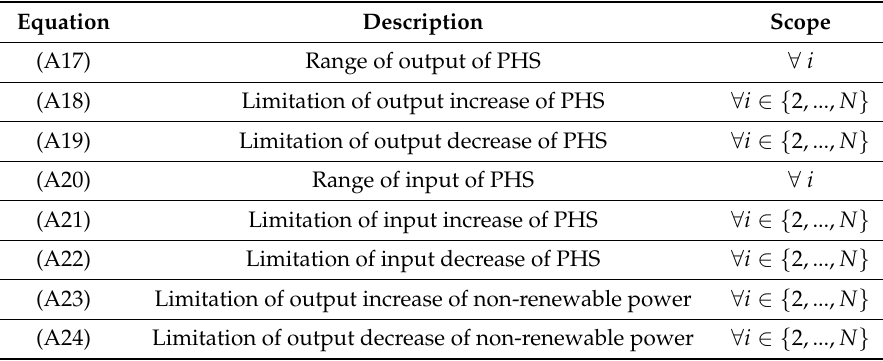
Table A7. Constraints of the power station.